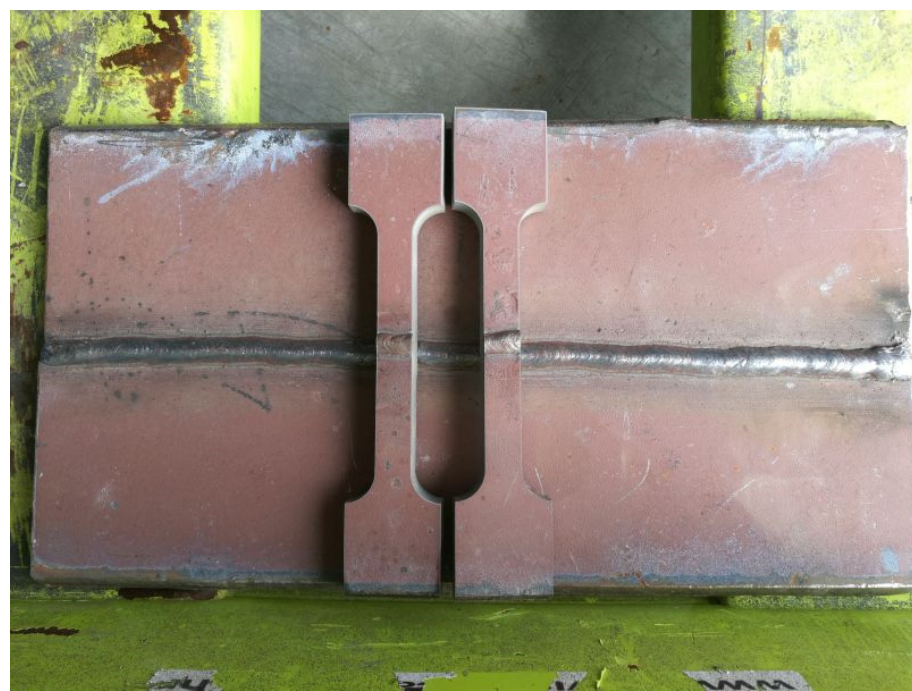
Figure 1. Welded blanks with cut out specimens.